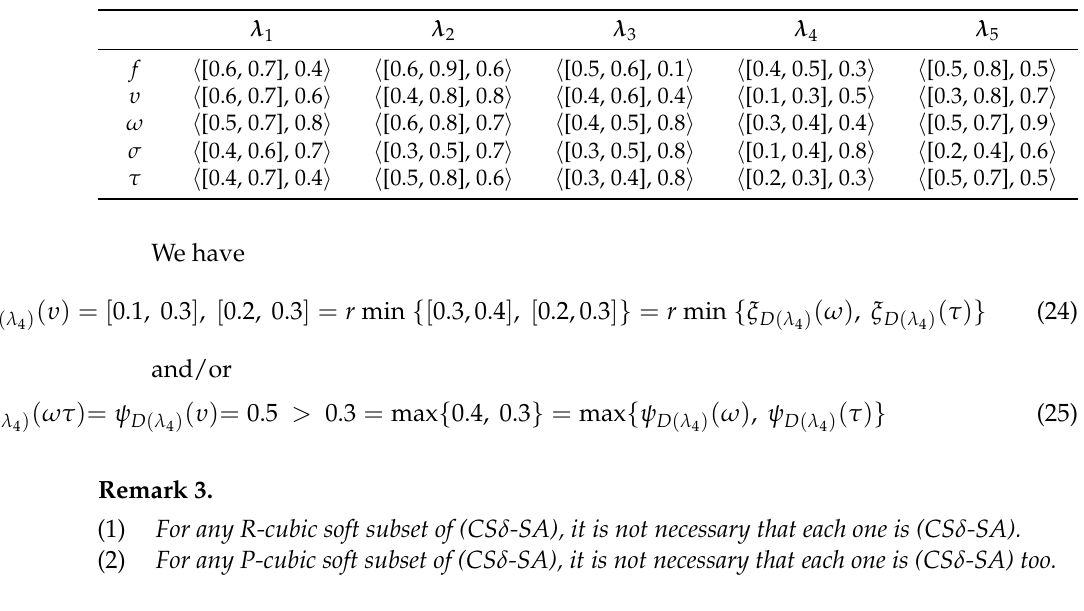
Here, (cid:60) and (cid:60) (cid:48) are not disjoint. The R -union ( D , W ) = ( Ω , (cid:60) ) ∪ p ( Ω (cid:48) , (cid:60) (cid:48) ) is given in Table 4. Table 4. ( D , W ) is